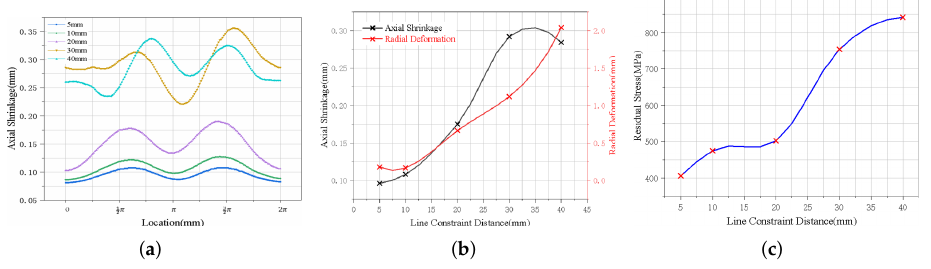
Figure 7. Stress and deformation at different line constraint distances: ( a ) deformation trend, ( b ) av- erage axial shrinkage and radial deformation, and ( c ) residual